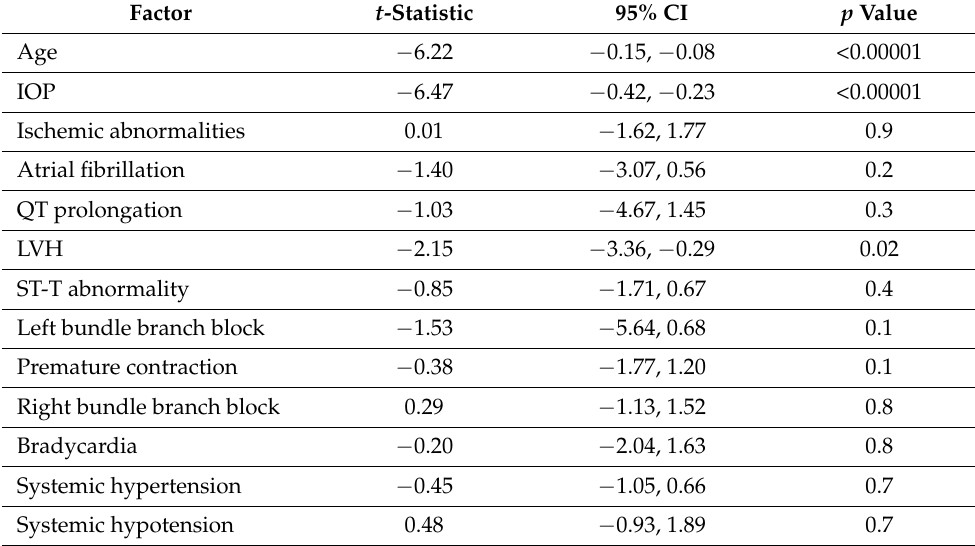
Table 3. Factors associated with glaucoma